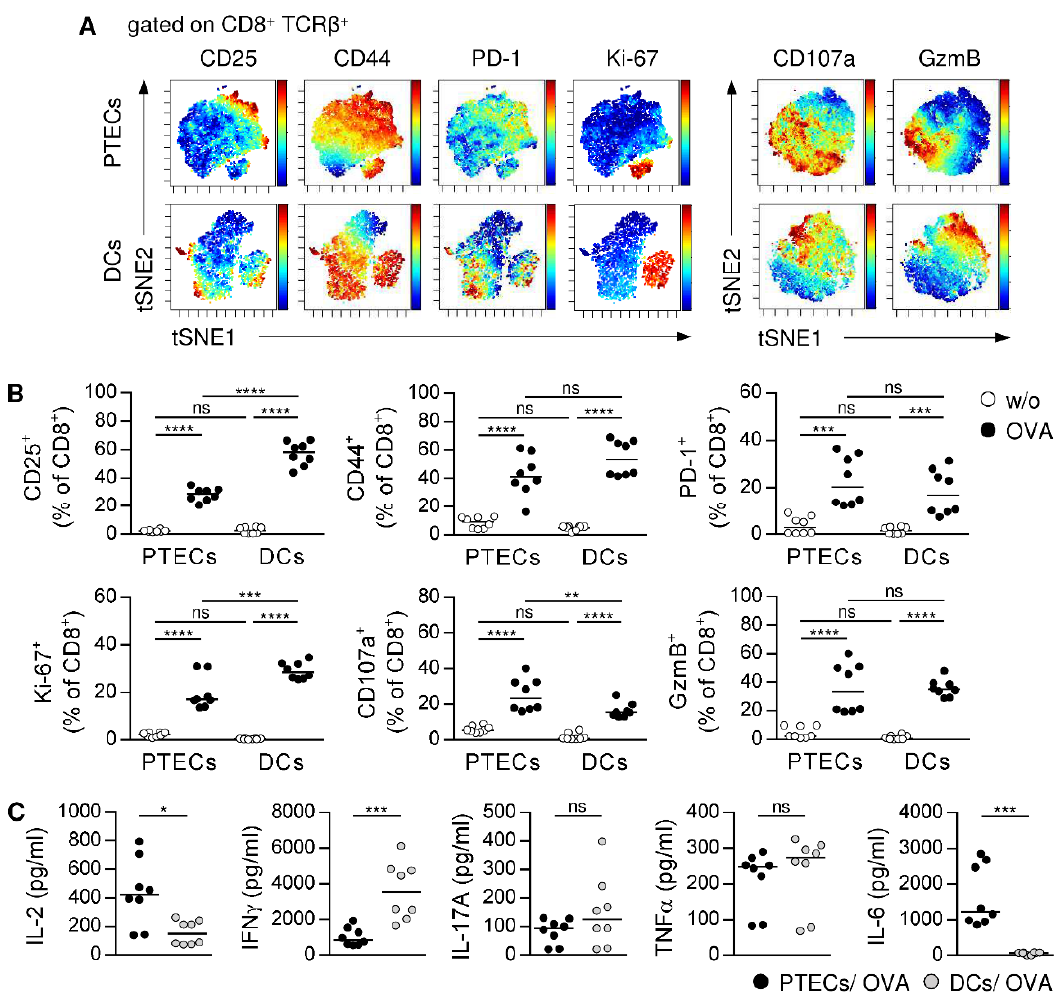
Figure 4. Phenotype analysis of CD8 + T cells activated by PTECs or splenic DCs. OVA-specific CD8 + CD25 − T cells were cultured with PTECs or DCs in presence or absence of OVA for 2.5 days. ( A ) CD8 + T cells from co-cultures were stained for CD25, CD44, PD-1, and Ki-67 or CD107a and GzmB and analyzed by viSNE analysis. Single cells are represented by dots and expression levels are color coded from minimal (blue) to maximal (red). The viSNE analysis comprises 7955 PTEC-activated and 7829 DC-activated CD8 + T cells. ( B ) Phenotype of CD8 + T cells from co-cultures were analyzed by flow cytometry. ( C ) Cytokine levels were determined in co-culture supernatants. Representative tSNE plots and medians of two experiments are shown. * p < 0.05; ** p < 0.01; *** p < 0.001; **** p < 0.0001; ns: not significant; w/o: without OVA.